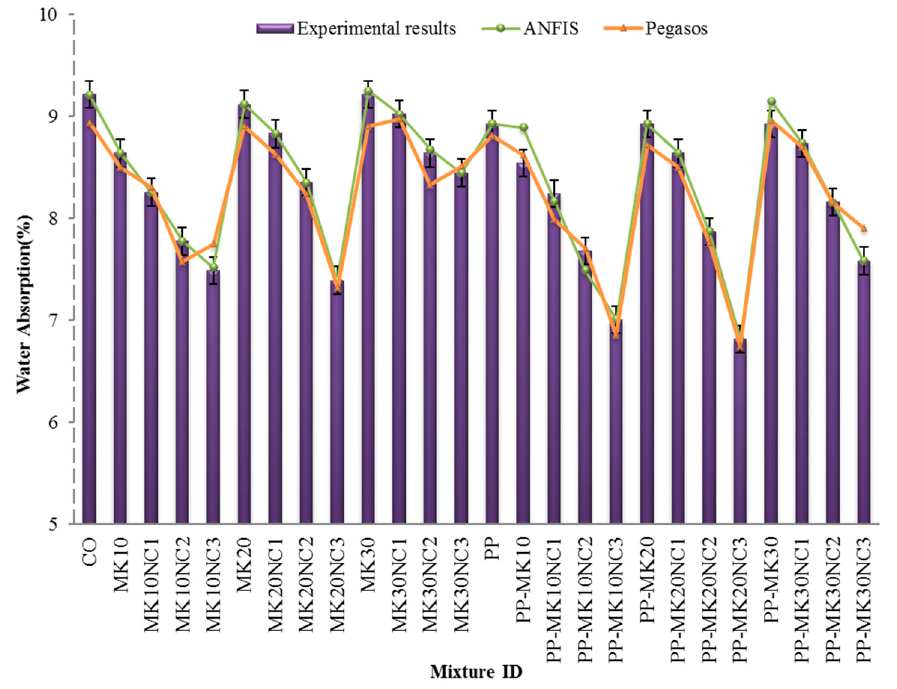
Figure 12. Water absorption of mortars at the age of 28 days.